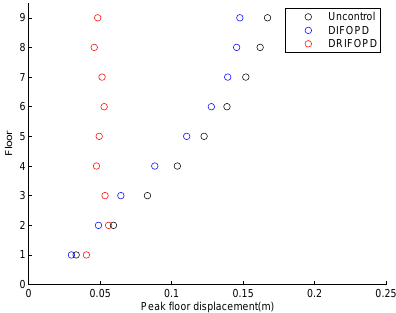
Figure 16. Maximum displacement of each floor under fault case